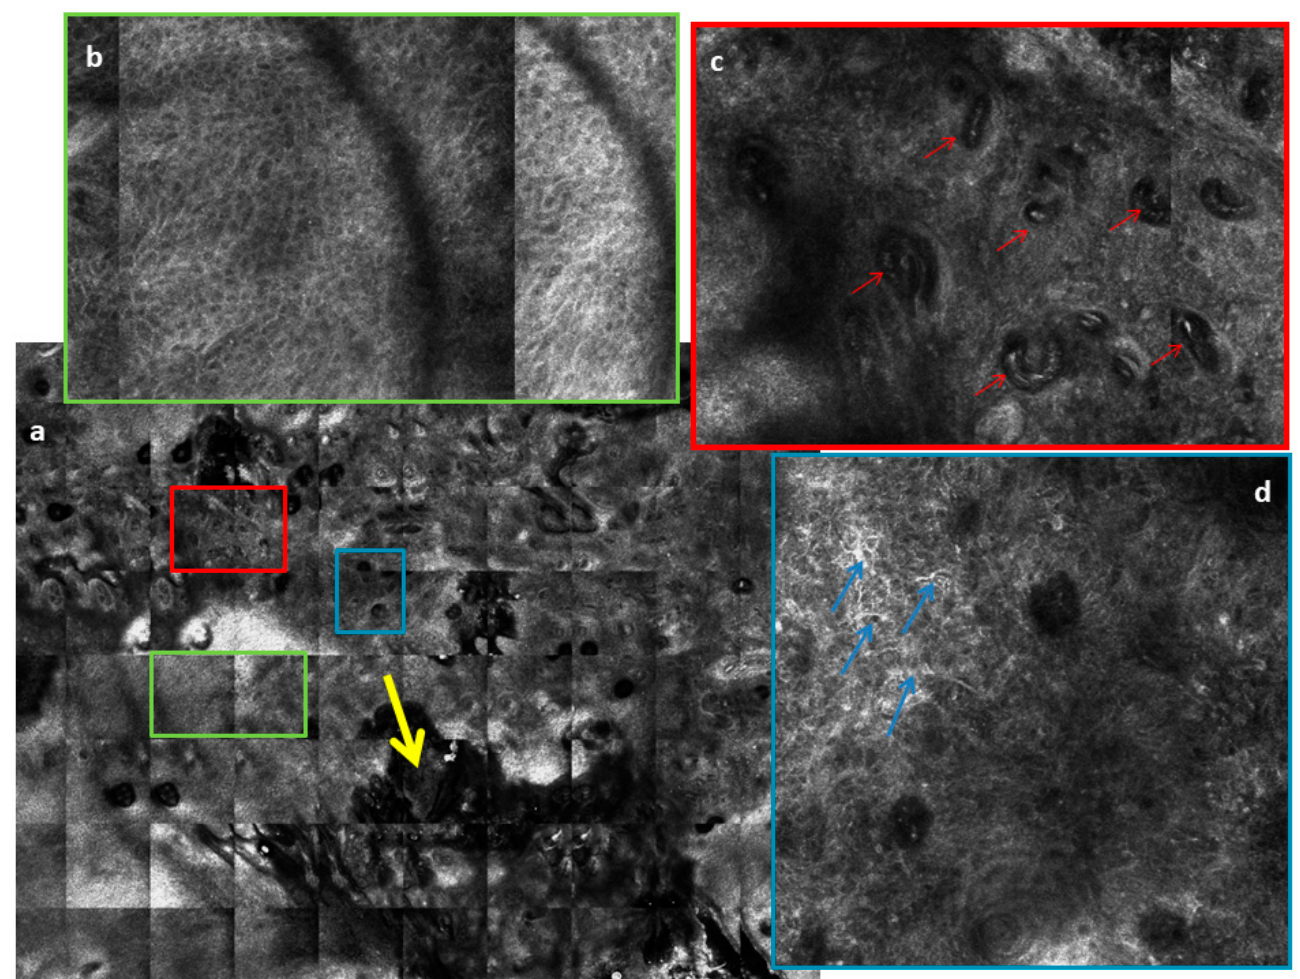
Figure 5. ( a ) Reflectance confocal microscopy (RCM) mosaic of a well differentiated cSCC (8 × 8mm). Yellow arrow shows a scale crust and ulceration in the lower part of the figure. ( b ) Green rectangle: a magnification of an RCM image (1 × 1.5 mm) at the epidermal layer shows atypical honeycomb pattern, which is characterized by thickened and broadened keratinocytes outlines of varying size and shape. ( c ) Red rectangle: a magnification of an RCM mosaic (1 × 1.5 mm) at the dermoepidermal junction layer shows round or coiled vessels (red arrows) that run through the dermal papillae perpendicularly to the lesion surface. ( d ) Blue rectangle: a magnification of an RCM mosaic (1 × 1 mm) at the spinous-granular layer shows a disarranged pattern characterized by architectural disarray and the presence of dendritic (blue arrows) and plump bright cells which represent pigmented keratinocytes and melanocytes infiltrating the epidermis.